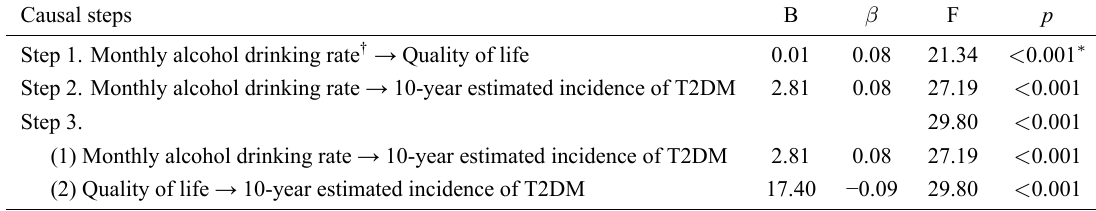
Table 3. Mediating effect of quality of life on the 10-year estimated incidence of T2DM in adult male Korean subjects. Causal